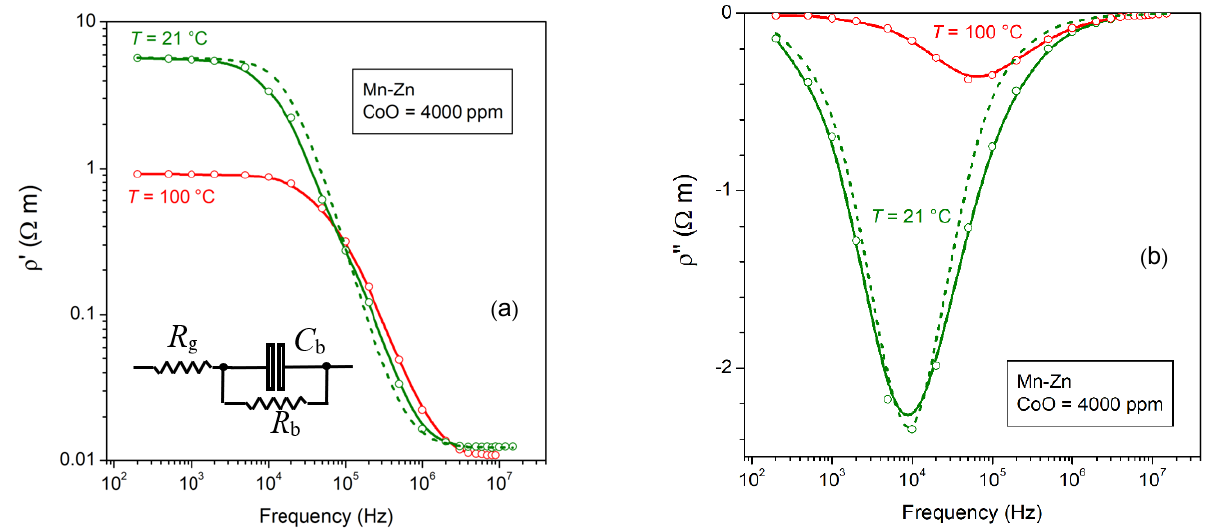
Figure 3 . An example of real ρ ′ (f) ( a ) and imaginary ( b ) ρ ″ (f) resistivity behaviors, as obtained by measurements with the four-point method up to 10 MHz on a CoO-doped Mn-Zn sintered ferrite. The observed dependences on frequency comply with an equivalent RC circuit, where C b and R b lump the capacity and resistance of the grain boundaries and R g << R b denotes the intragrain resistance. The dashed lines are predicted by the relaxation Equation (5). To note the limiting lower value attained by ρ ′ (f) in the MHz range where it reduces to the intragrain resistivity ρ g . (Partly adapted from Ref. [24])